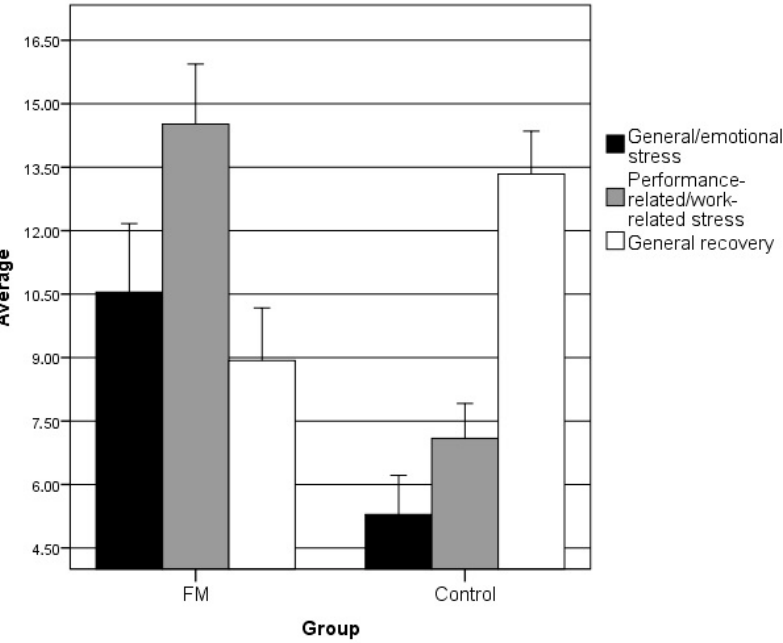
Figure 1. Average score of the groups in each of the REST-Q factors. As expected, stress levels were higher in the FM group and recovery levels were higher in the healthy group.